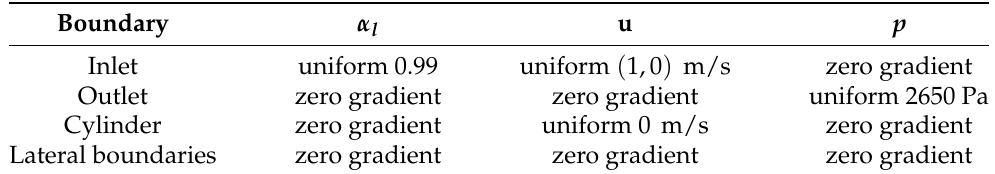
Table 5. Boundary conditions for the simulation of the two-dimensional laminar flow around the cylinder.